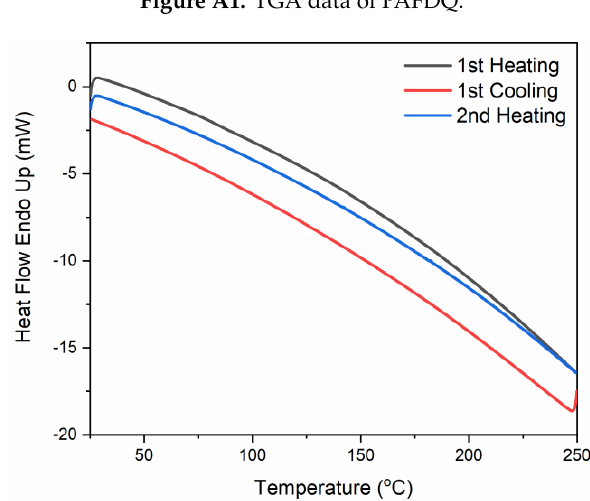
Figure A2. DSC curves of PAFDQ.